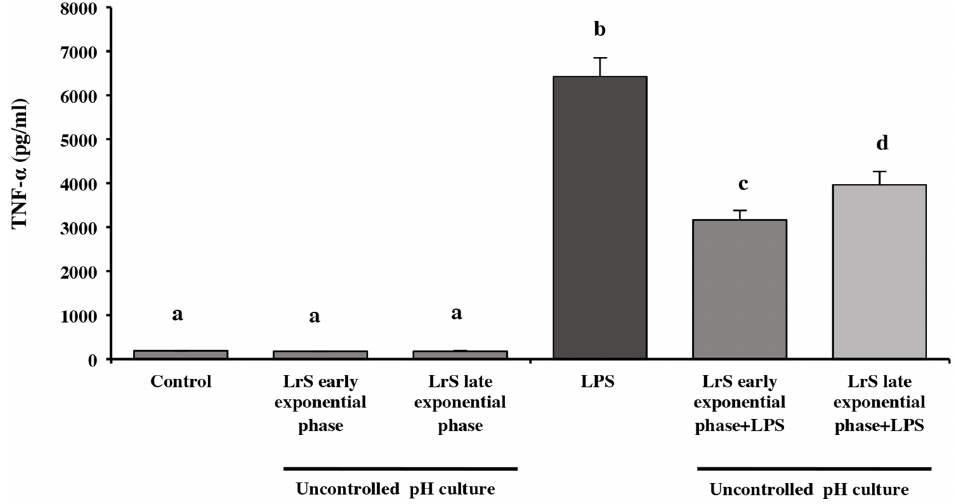
Fig 5. Effect of LrS on TNF- α production by RAW 264.7 cells. LrS production by bacteria grow in PETG medium in early and late exponential growth phase was evaluated in RPMI 1640 medium, and their anti-inflammatory effect was checked on LPS challenged RAW cells. TNF- α production was measured in culture supernatants by ELISA. Data shown are a representative result of three independent experiments. Values not sharing the same letter were significantly different ( p -value <